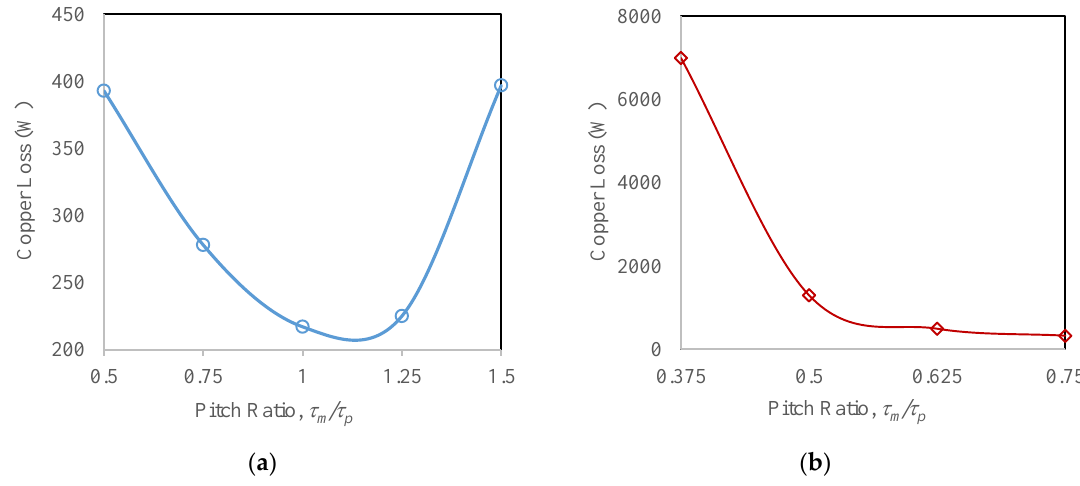
Figure 18. Influences of Pitch Ratio, m / p on Copper Loss for ( a ) TPMLM-NS; ( b ) TPMLM-S.